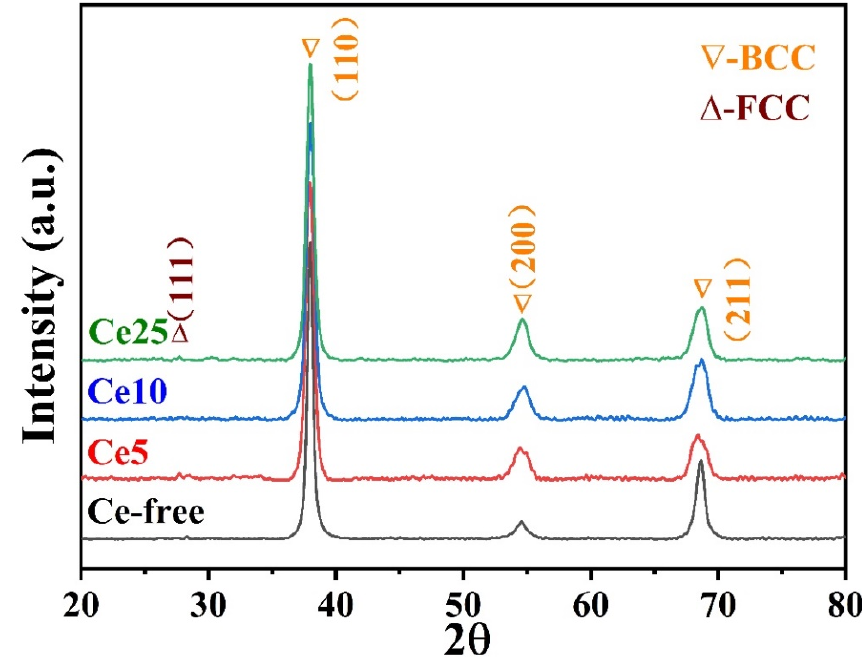
Figure 1. XRD patterns of CeX.